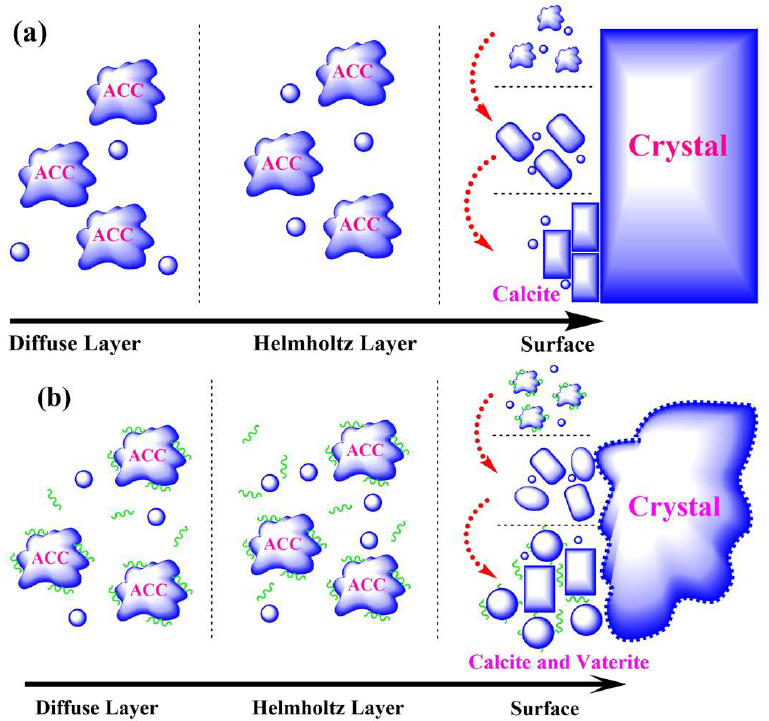
Figure 12. The schematic diagram of ACC conversion. In the absence of a PASP ( a ); in the presence of PASP ( b